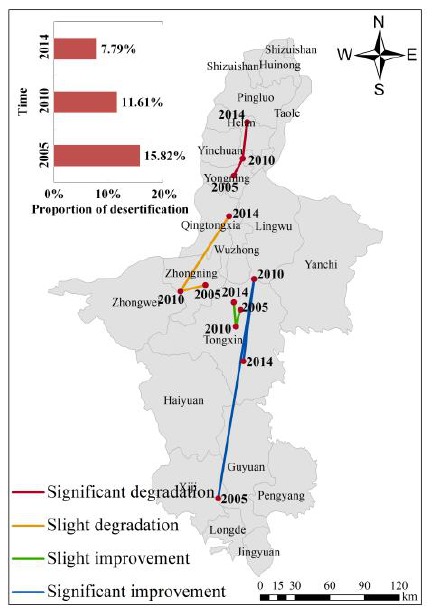
Figure 5. Proportion and gravity migration of desertification